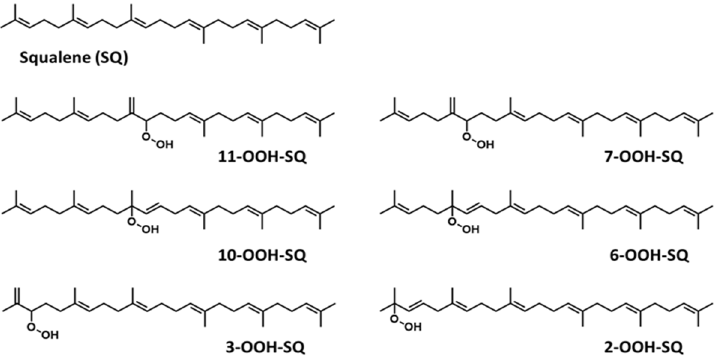
Figure 1. Chemical structure of unoxidized squalene (SQ) and its six singlet oxygen monohydroperoxide products (SQ-OOH isomers).